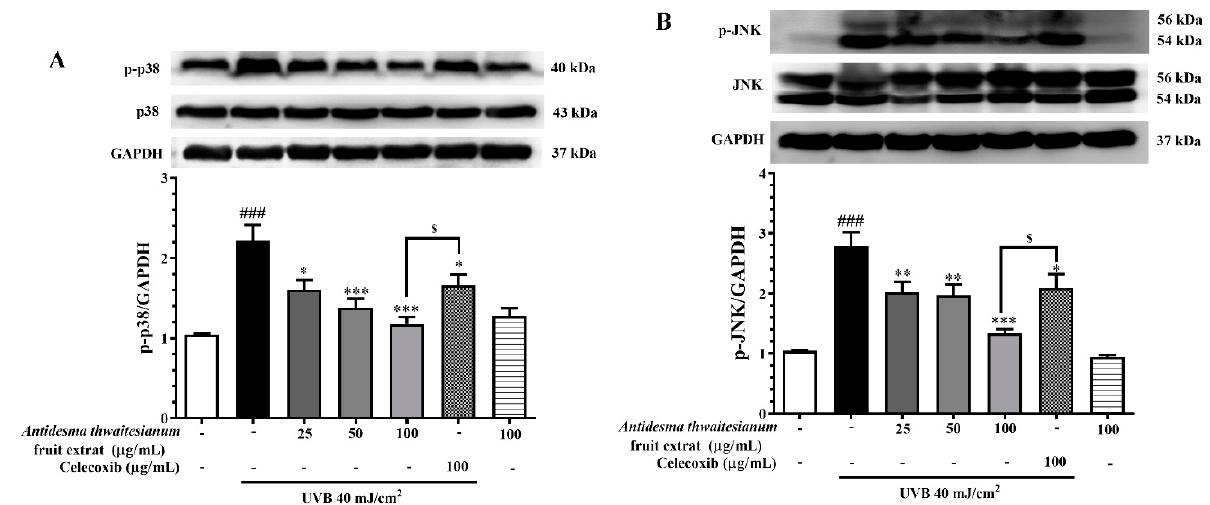
Figure 6. The dose-dependent effects of the fruit extract on p38 and JNK phosphorylation. Cells were pre-incubated with the fruit extract for 2 h before exposure to single UVB irradiation and further incubated for ( A ) 6 h and ( B ) 1 h. The proteins of interest were determined by Western blot analysis. The results are presented as mean ± SEM (n = 8) and analyzed with Tukey’s test. ### p < 0.001 versus the control group; * p < 0.05, ** p < 0.01, and *** p < 0.001 versus UVB-irradiated cells alone. The statistical difference between the extract and celecoxib at 100 µg/mL was at $ p < 0.05.